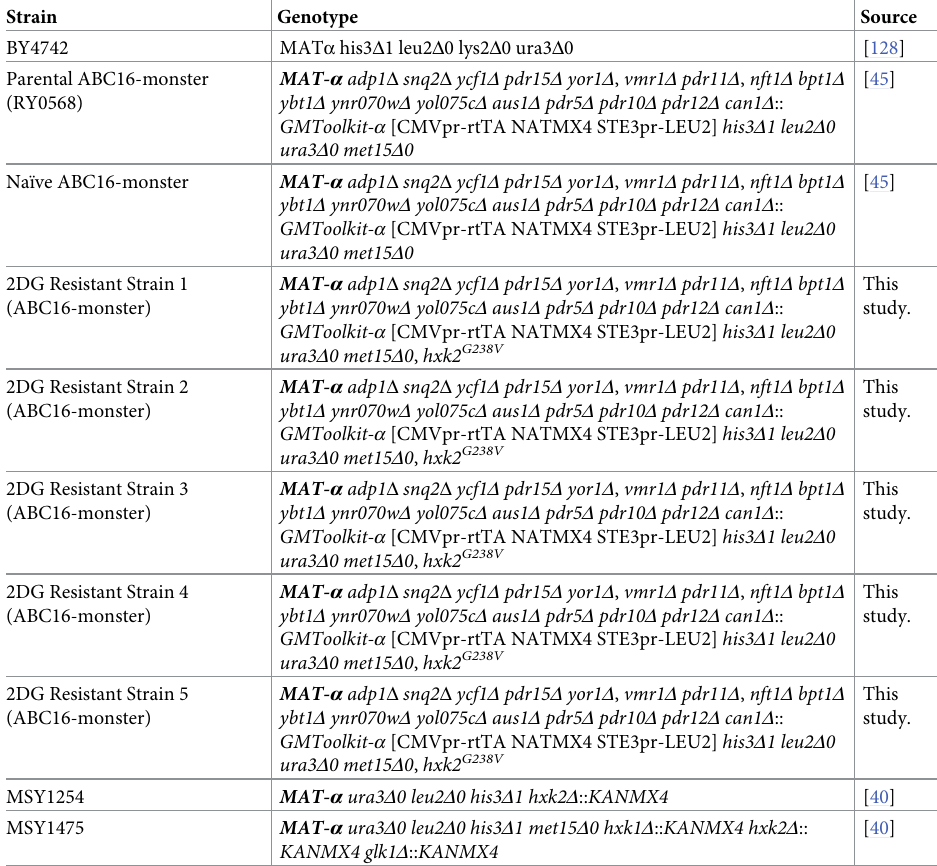
Table 3. Yeast strains used in the current